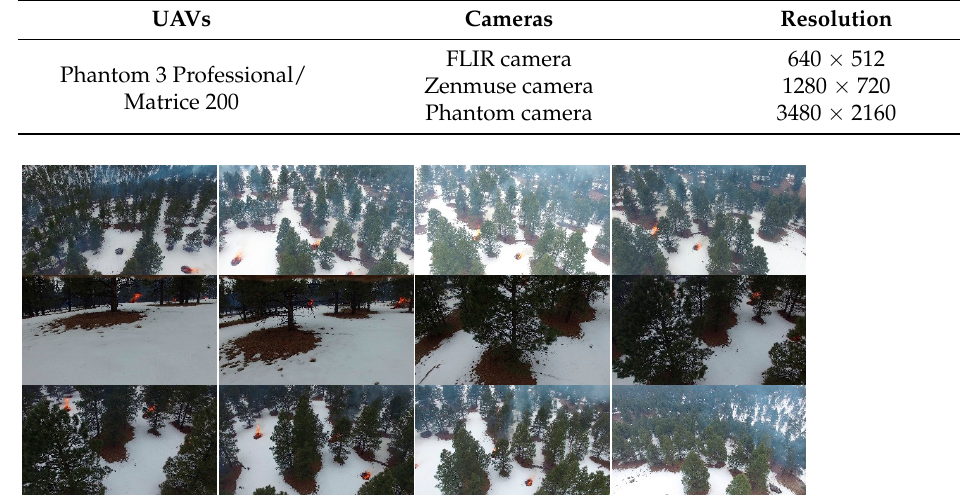
Figure 1. Some image samples of forest fires in the FLAME dataset.